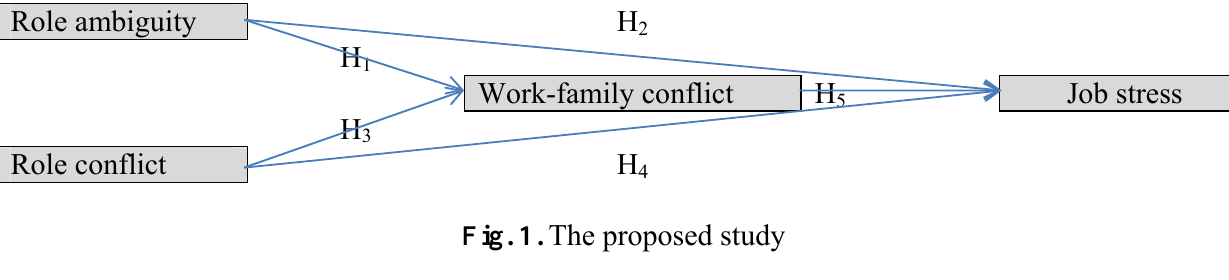
Fig. 1. The proposed